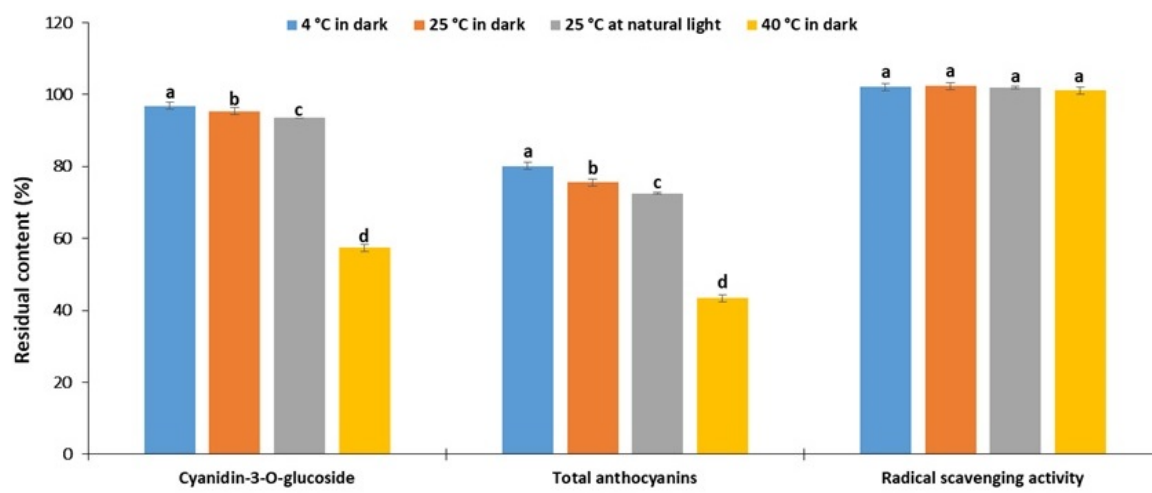
Figure 2. The residual content of anthocyanins and radical scavenging (DPPH) activity after 30 days of storage under different conditions. a–d—the different letters above the bars represent a significant difference in residual contents between samples stored at the various condition with a significance level of 0.05 according to ANOVA with Tukey’s post hoc test.